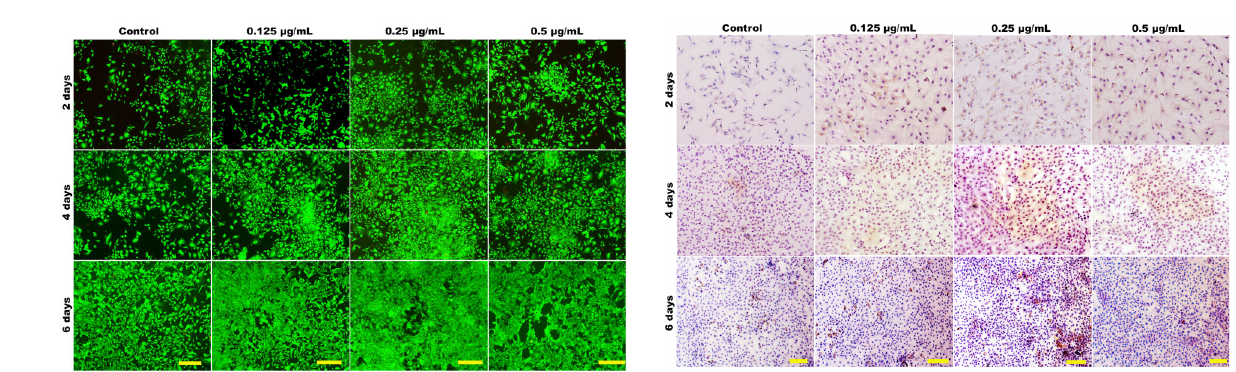
Figure 6. Laser-scanning confocal microscopy images showing the viability of chondrocytes cultured in vitro with 0 (control), 0.125, 0.25, and 0.5 mg/mL JJYMD-C for 2, 4, and 6 days. Scale bar: 100 mm.